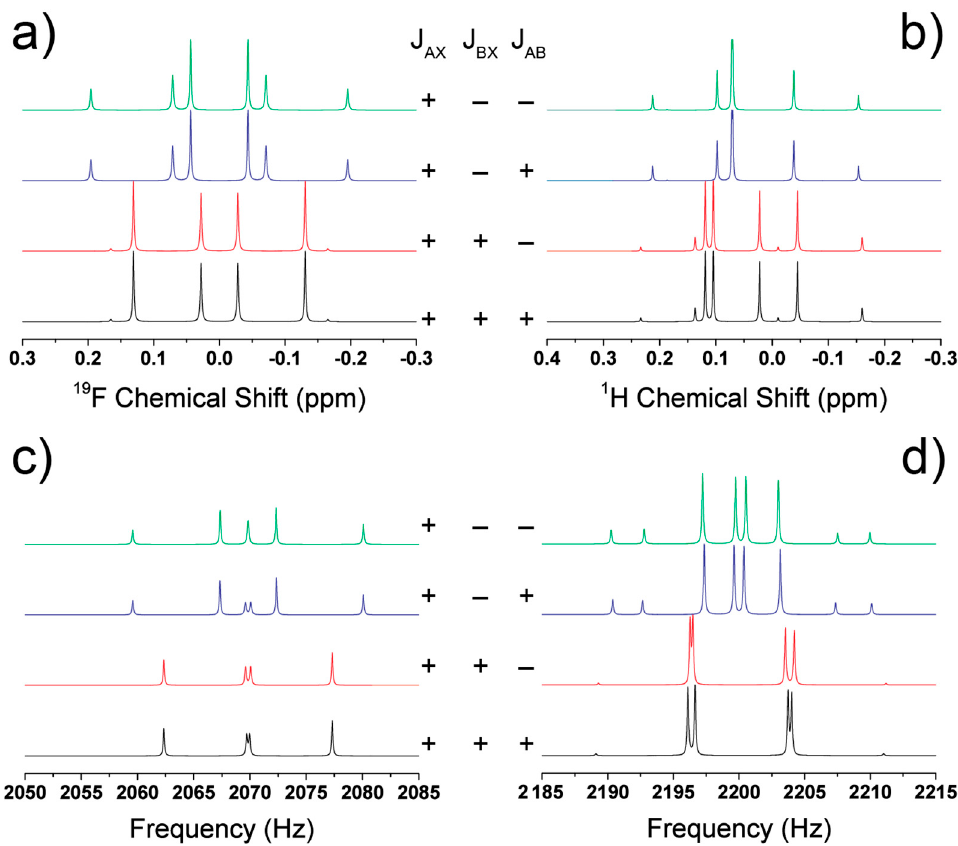
Figure 10. The 19 F ( a ) and 1 H ( b ) high field NMR spectra of an ABX system, with J -couplings J AX = 10 Hz, J BX = 5 Hz, and J AC = 7 Hz. Note that the spectra were invariant to the relative sign of J AB and only depended on the relative sign of J AX and J BX . In spectra ( c ) and ( d ), the same spin system was in the strong heteronuclear J -coupling limit, such that the ABX system became the ABC system. Unlike the ABX system, which only has two distinct spectra, the ABC system has four distinct spectra. Therefore, the relative signs of all three J -couplings may be determined for the ABC system. The absolute signs of the J -couplings are denoted between the spectra and are consistent between the high field and LF spectra with black ( + + + ), red ( + + − ), blue ( + − + ), and green ( + − − ).